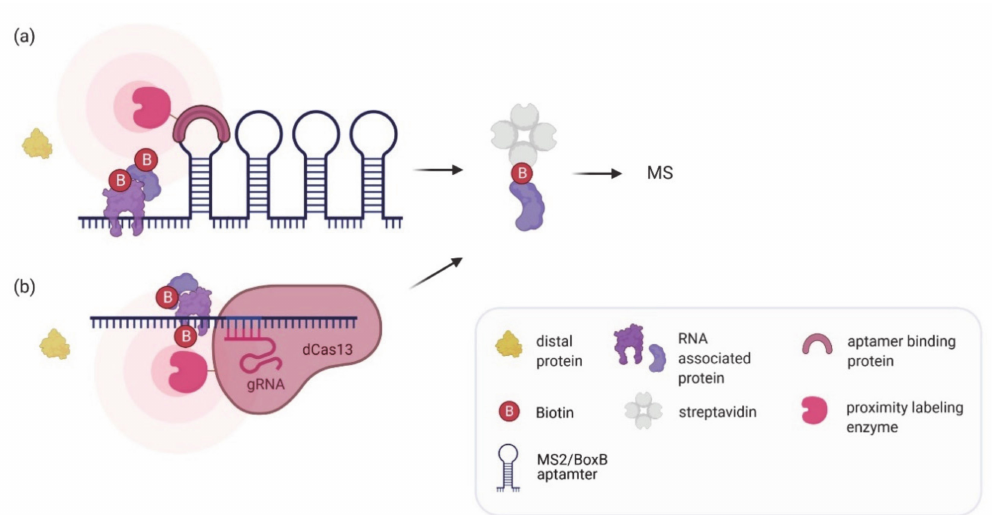
Figure 3. In vivo proximity labeling strategies for identifying protein partners of an RNA of interest. ( a ) The RNA of interest is tagged endogenously or exogenously with aptamers (e.g., BoxB aptamer or MS2 tags) to recruit an aptamer binding protein fused to a labeling enzyme which can biotinylate associated proteins. ( b ) A catalytically inactive dCas13 enzyme fused to a labeling enzyme is targeted to the RNA of interest using a gRNA to biotinylate associated proteins. In both methods biotinylated proteins are enriched by streptavidin pulldown and analyzed by mass